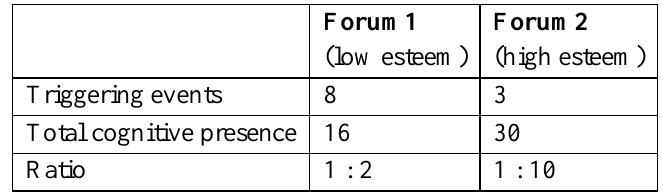
The Ratio of Instructors’ Triggering Events with Cognitive Presence